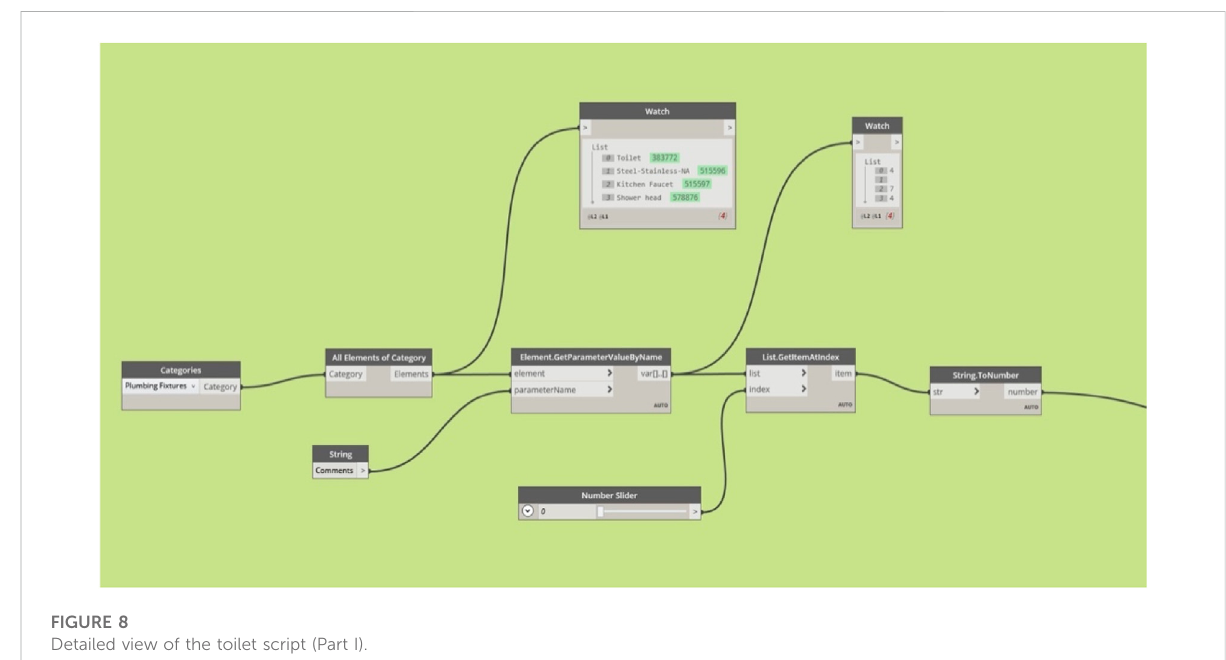
FIGURE 8 Detailed view of the toilet script (Part